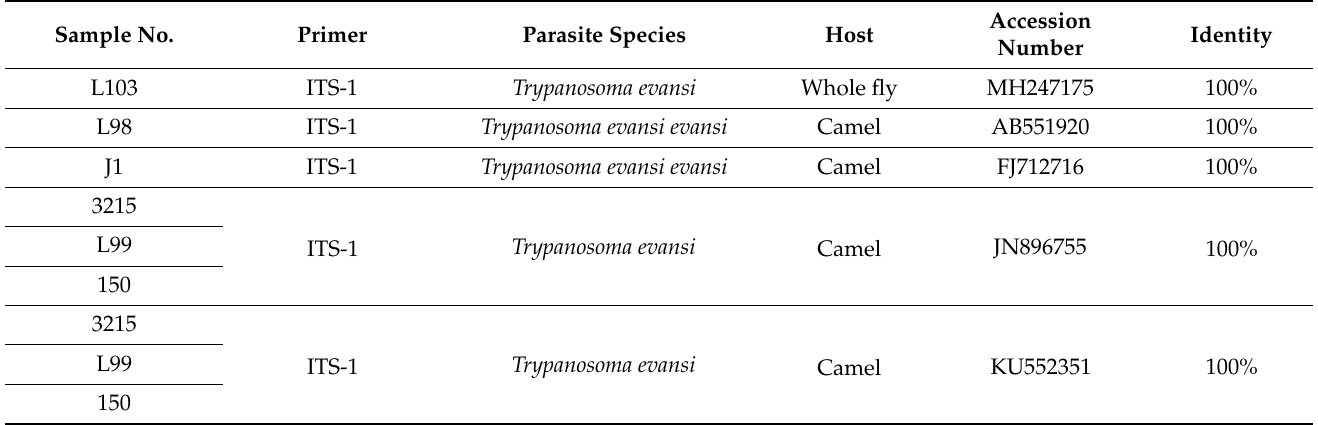
Table 2. Parasite species isolated from camels using